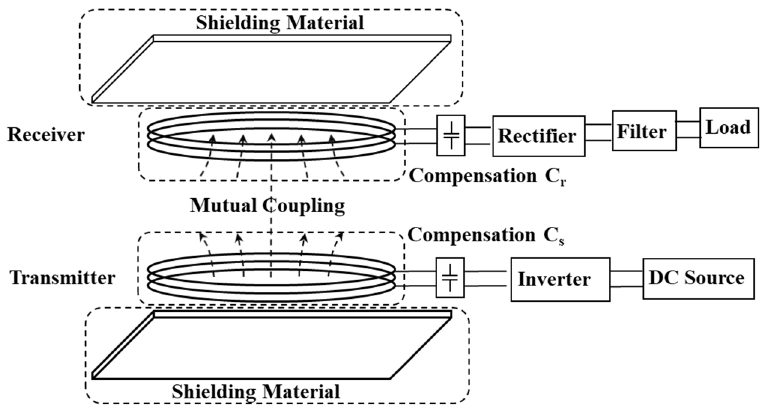
Figure 2. Schematic diagram of field circuit structure of electric vehicle wireless power transmission system loaded with shielded aluminium plates.